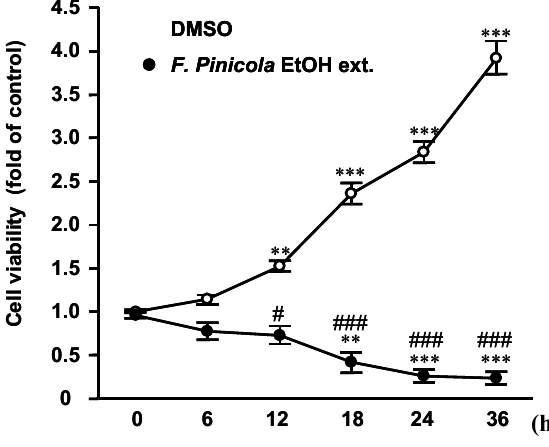
Figure 2. Ethanol extract of F. pinicola inhibits S-180 cells proliferation in a time-dependent manner. Sarcoma S-180 cells were treated with F. pinicola ethanol extract at a dose of 12.5 µg/mL for various durations as indicated. Cells were then incubated with 0.2 mg/mL MTT in culture medium for 4 h. MTT reagent was discarded and DMSO was added. The absorbance was measured at the wavelength of 570 nm. The data is expressed as means ± S.E.M and obtained from three independent experiments with four replicates for each experiment. * p < 0.05, ** p < 0.01 and *** p < 0.001 compared with the control group. # p < 0.05 and ### p < 0.001 compared with the F. pinicola ethanol extract-treated